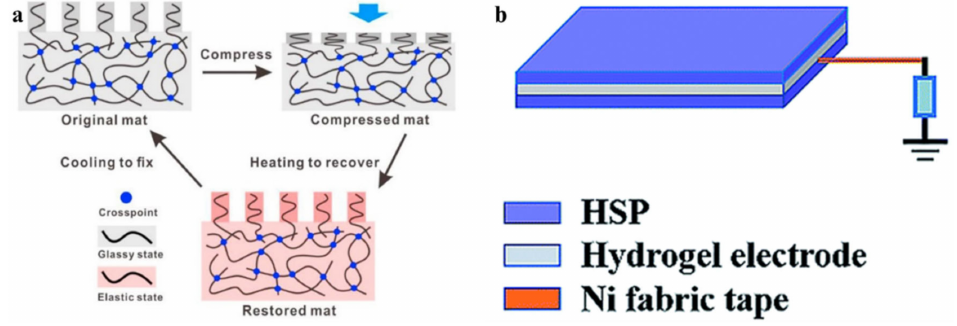
Figure 60. ( a ) Schematic depiction of recovery process of microstructural shape memory PU upon heating. Reprinted with permission from [254]. Copyright (2020) American Chemical